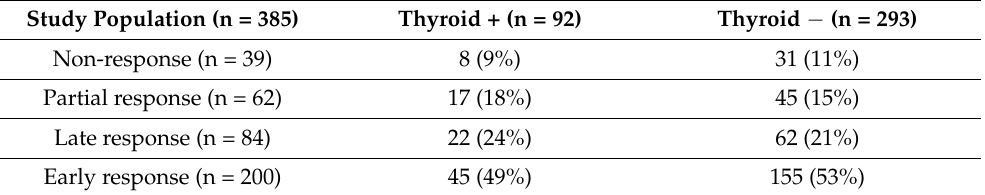
Clinical response to omalizumab in 385 urticaria patients with and without thyroid